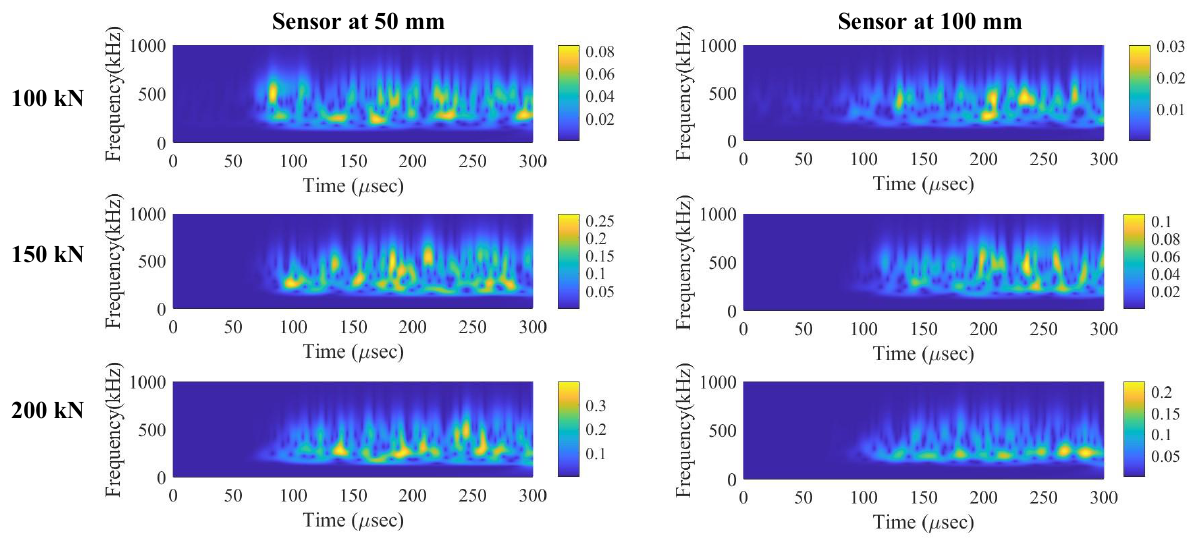
Figure 15. Raw, filtered and FFT of AE signals occurring at load = 200 kN.